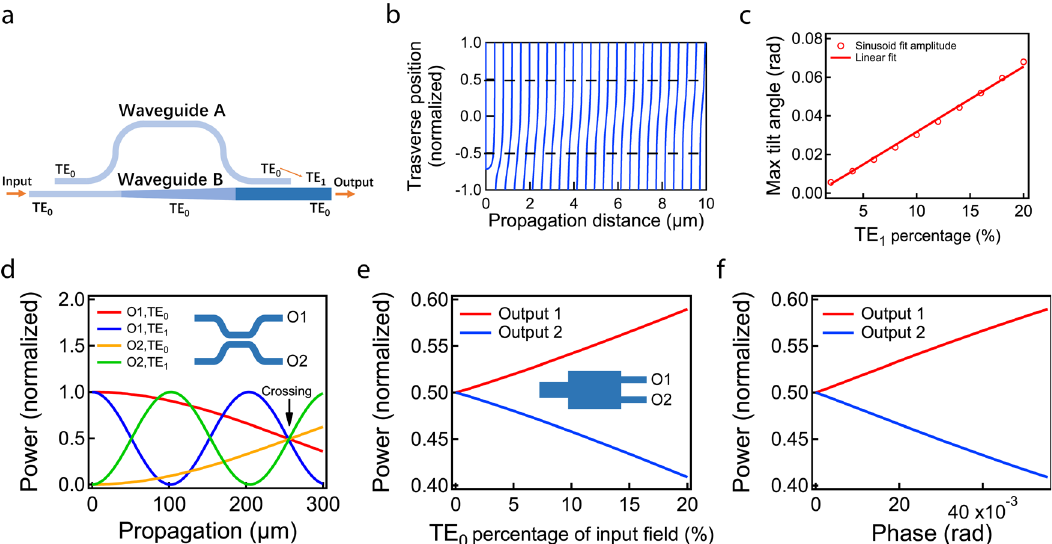
Fig. 2 Individual components. a Spatial phase front tilter that couples a portion of TE 0 mode to TE 1 mode to create spatial phase front tilt in waveguides. b Phase front contour map along propagation of a combination of TE 0 and TE 1 (7:3). The ratio is exaggerated to show the effect of the tilted phase front. c Phase front tilt angle vs. the fi eld percentage of TE 1 mode (details in Supplementary Note 2). d coupler consists of two identical multimode waveguides. Simulation of power in multimode directional coupler along propagation. Coupling length is chosen to obtain a 50:50 beam splitter for both modes. e Multi mode interfering region with a multimode waveguide input and two single mode waveguide outputs. Multimode interfering waveguide and simulation of its output power vs. input TE 1 mode percentage. Power is normalized to the total power of the two outputs, which is the total power on the detector. f Normalized power detection vs. applied phase shift signal (details in Supplementary Note